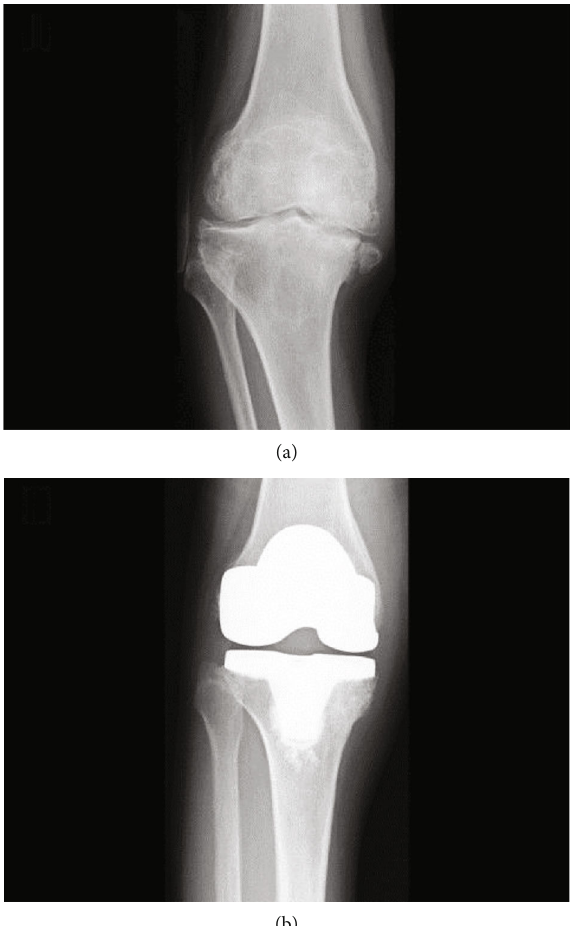
Figure 1: (a) Preoperative radiograph of the left knee showing severe varus. (b) Postoperative radiograph after left TKA.